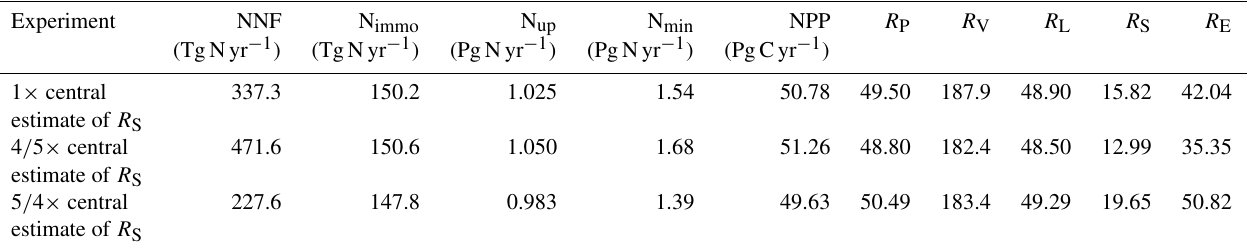
Table 1. Modelled global NNF in steady state, including the range due to uncertainty in the soil C:N ratio (steady-state runs with e = 0 . 175). NNF, ecosystem demand for newly fixed N; N immo , N immobilization rate; N up , N uptake rate; N min , N mineralization rate; NPP, net primary production; R P , C:N ratio of production; R V , C:N ratio of vegetation; R L , C:N ratio of litter; R S , C:N ratio of soil organic matter; R E , C:N ratio of ecosystems. Experiment